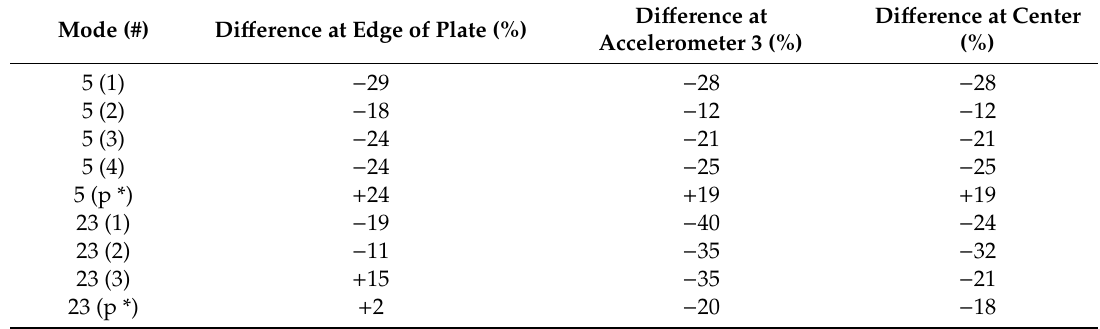
Table 9. Di ff erence of the numerical model prediction with experimental results for modes with cracking of the ice.